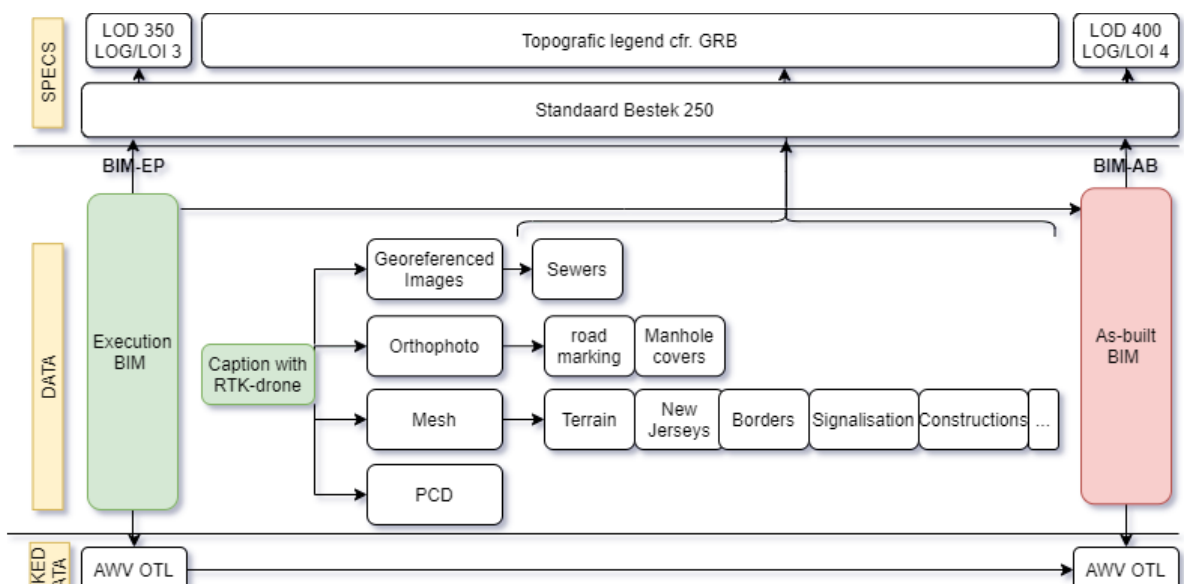
Figure 2. Methodology for road construction monitoring. An overview of the Linked Data and BIM data structure for the estimation of the quality, quantity and progress